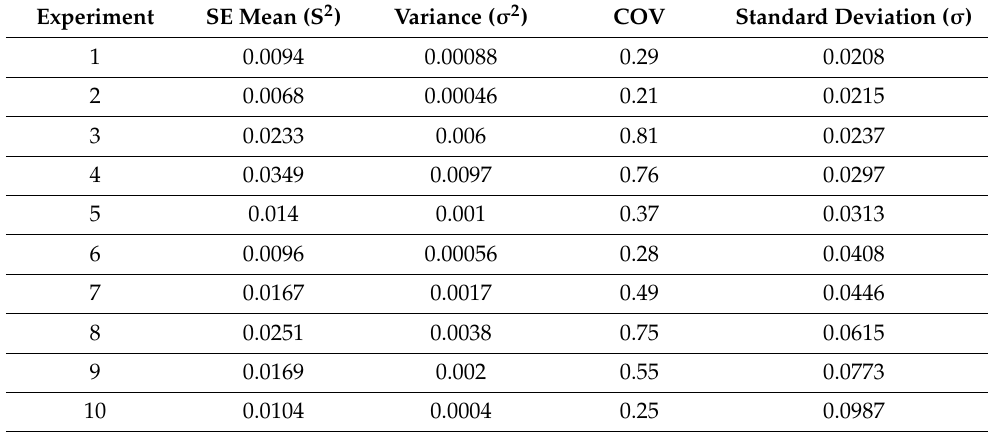
Table 1. Repeatability